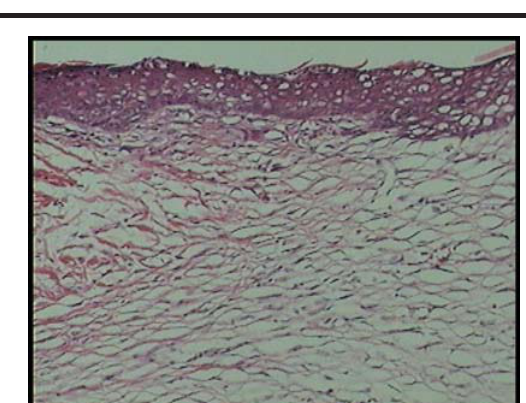
FIGURE 3 - Histological section of wound tissue taken from a SAL group rat, demonstrating significant neutrophil infiltration, giant cells and folicules. HE,